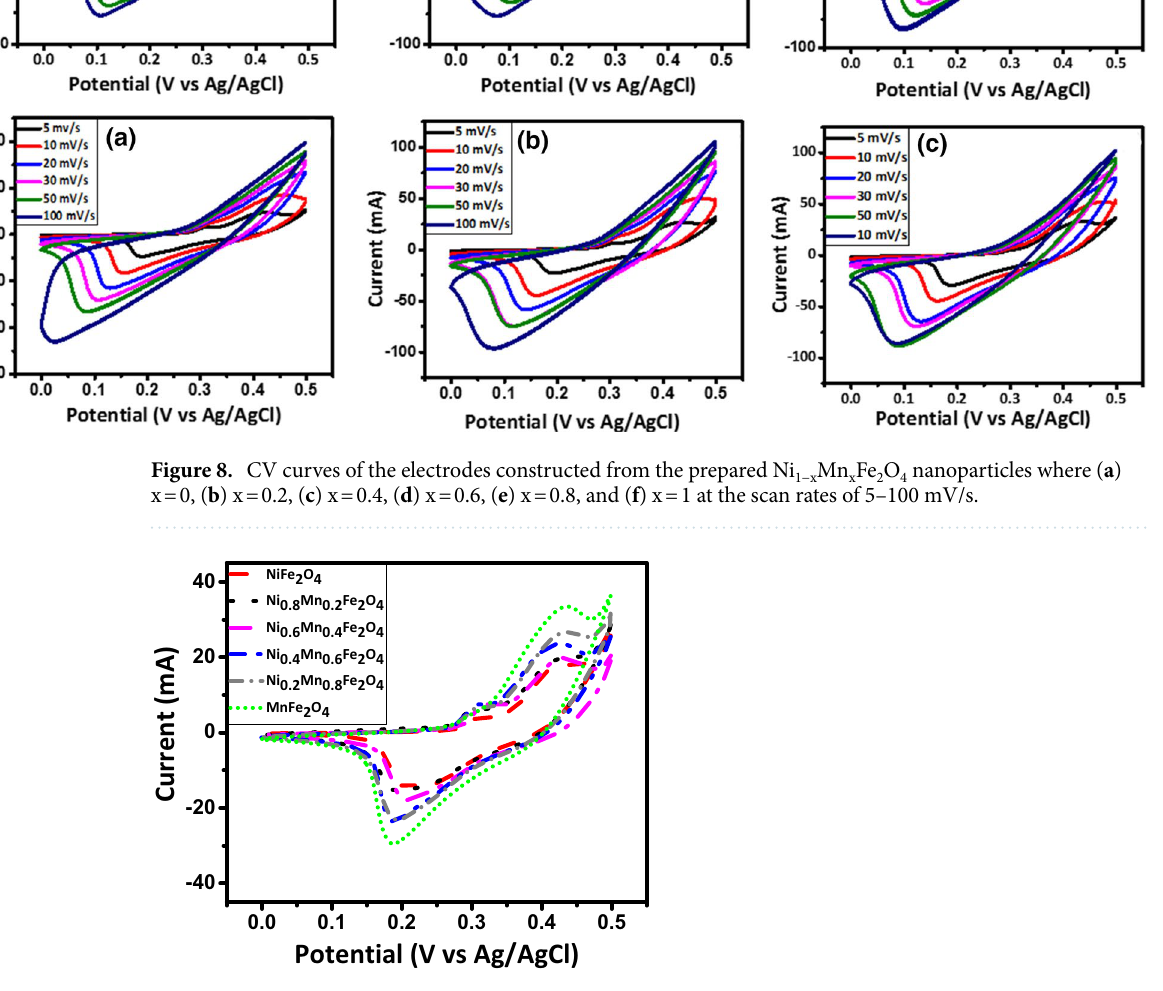
of the Ni 1−x Mn x Fe 2 O 4 -based electrodes, resulting from the decreased bandgap of Ni 1−x Mn x Fe 2 O 4 nanoparticles for a higher x, which itself enhances faradaic reactions at the electrode surface and enhances the specific capacitance. Galvanostatic charge–discharge (GCD) curves of the samples at different current densities for three-electrode tests are shown in Fig. 10. The nonlinear discharge curves show that the capacitive performance results from both the electric double-layer capacitance and the pseudocapacitance 31 . The potential drop observed at the beginning of the discharge curve indicates both the very low internal series resistance (R s ) of the prepared electrodes in the KOH electrolyte and the low contact resistance at the interface of the current collector and the electrolyte 25 .